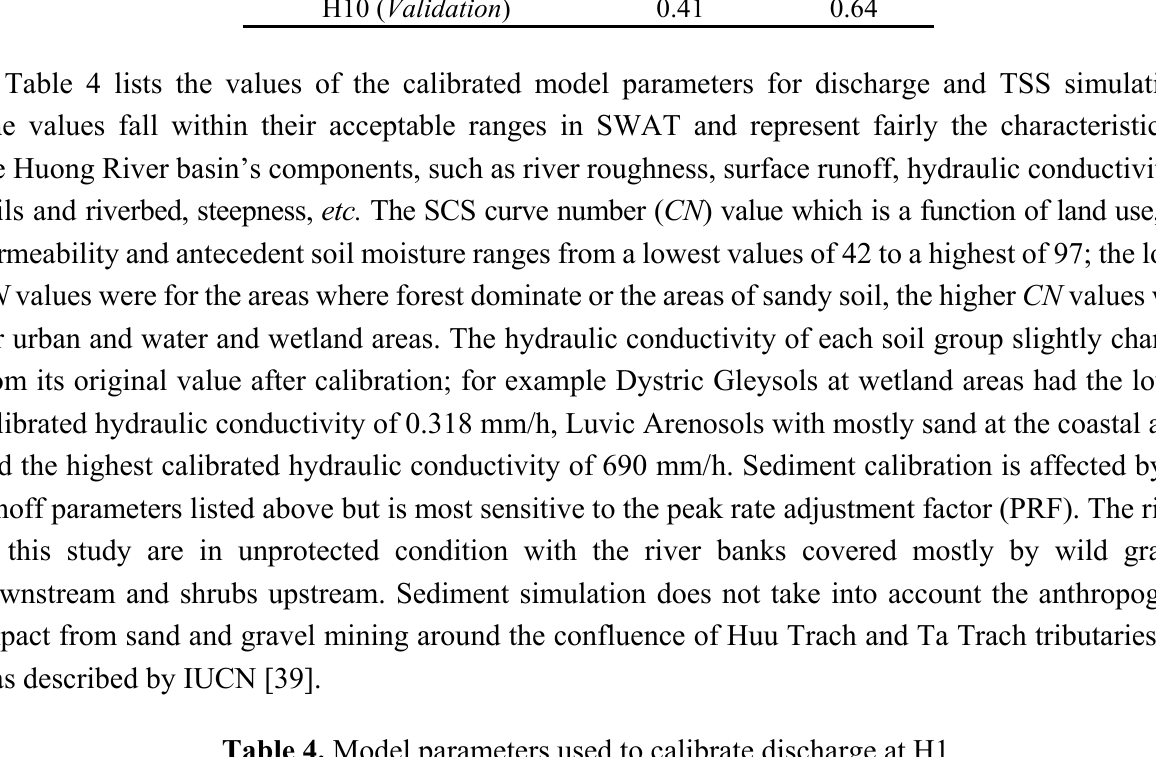
Table 4. Model parameters used to calibrate discharge at